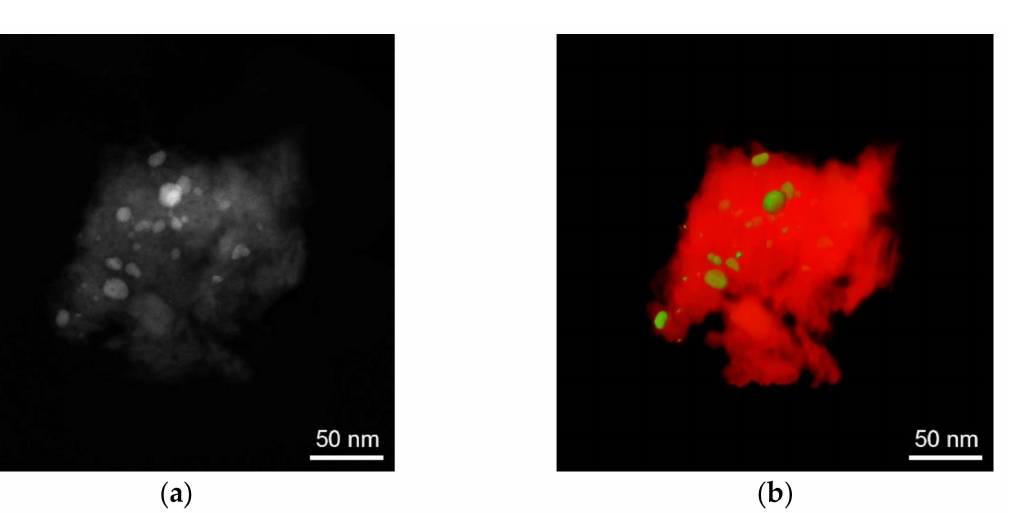
Figure 4. Results of electron tomography of the 10 wt% Fe/Al 2 O 3 catalyst. ( a ) 2D image of the surface consisting of particles and support; ( b ) reconstructed 3D image of both the particles and the support. The support (Al 2 O 3 ) is marked in red colour, and the Fe particles are marked in